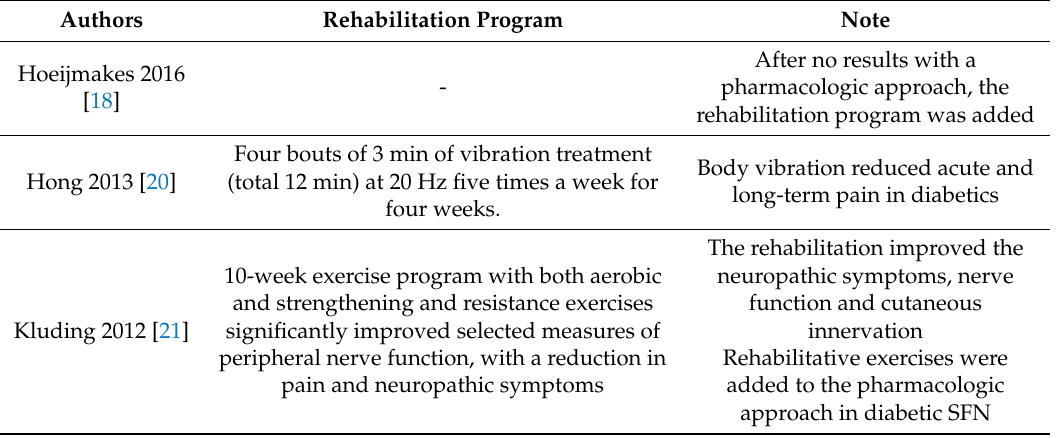
Table 2. Rehabilitation